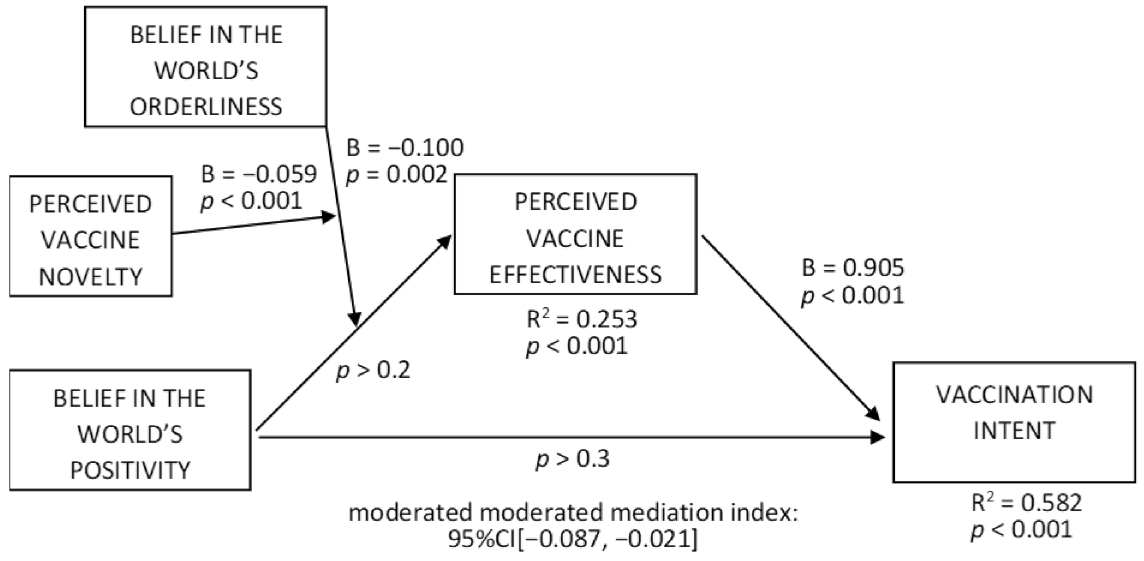
Figure 8. Moderated moderated mediation effects on vaccination